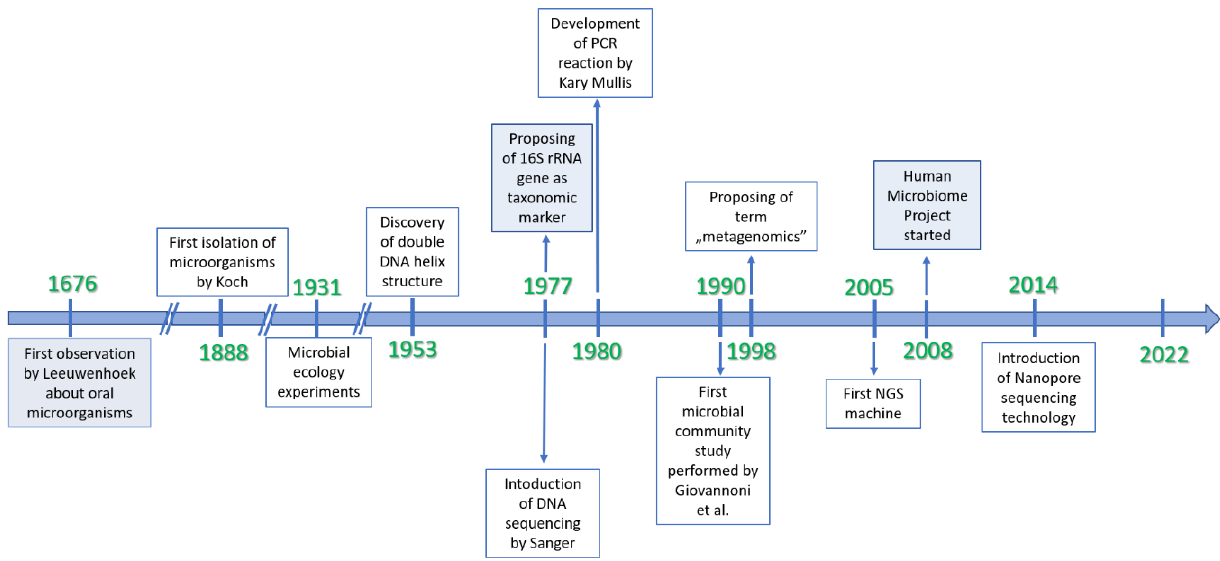
Figure 3. The most significant events in metagenomics over time.